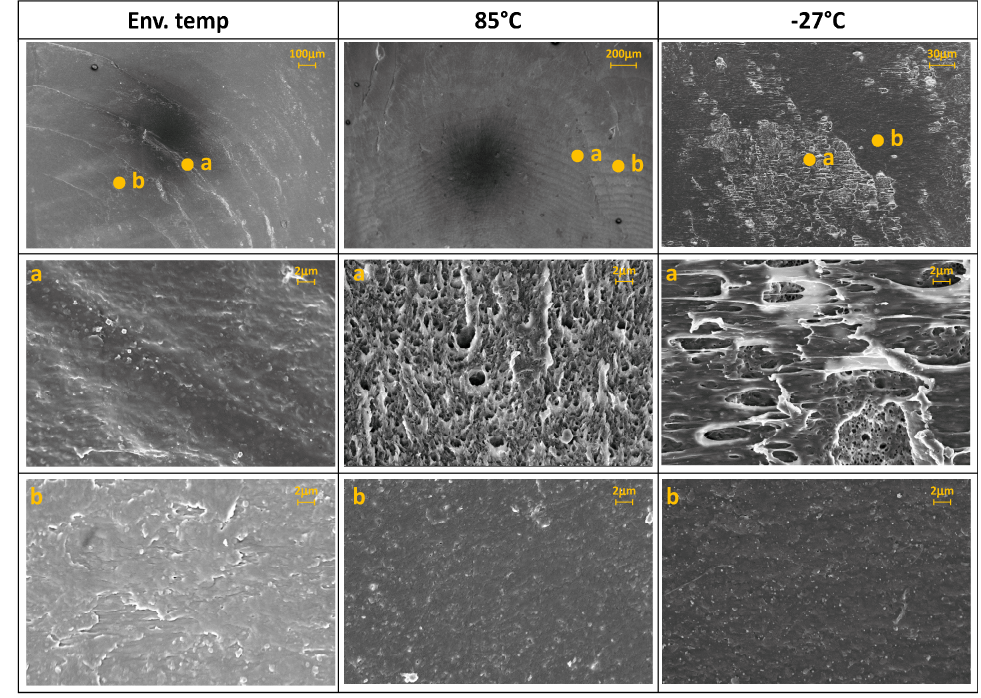
Figure 18. FESEM images of ABS growth bands at different test temperature and magnification of the arrest band ( a ) and between bands ( b ).